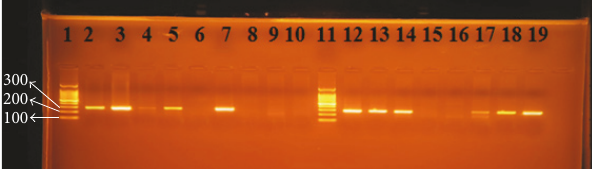
Figure 1: PCR products for H. pylori with glmM (ureC) gene-based primers. The product size is 294 bp. Lanes 1 and 11 are ladders.